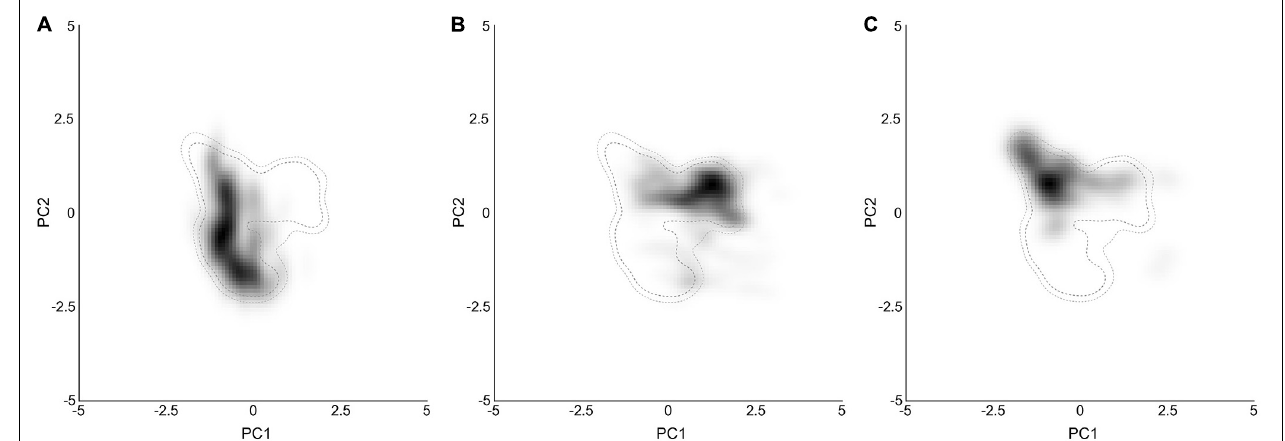
FIGURE 3 | Ecological niches of the three analyzed subclades within the Chrysanthemum -group in environmental space produced by the principal component analysis method. The PCA results of (A–C) represent the niches of the lineages in the two main axes with the environmental conditions of sampled occurrences for Ajania , Ch. indicum -complex and Ch. zawadskii -complex, respectively. The gray-to-black shading shows the density of the occurrences by cell. The outer and inner dashed contour lines illustrate 100 and 95% of the available (background) environment, respectively.